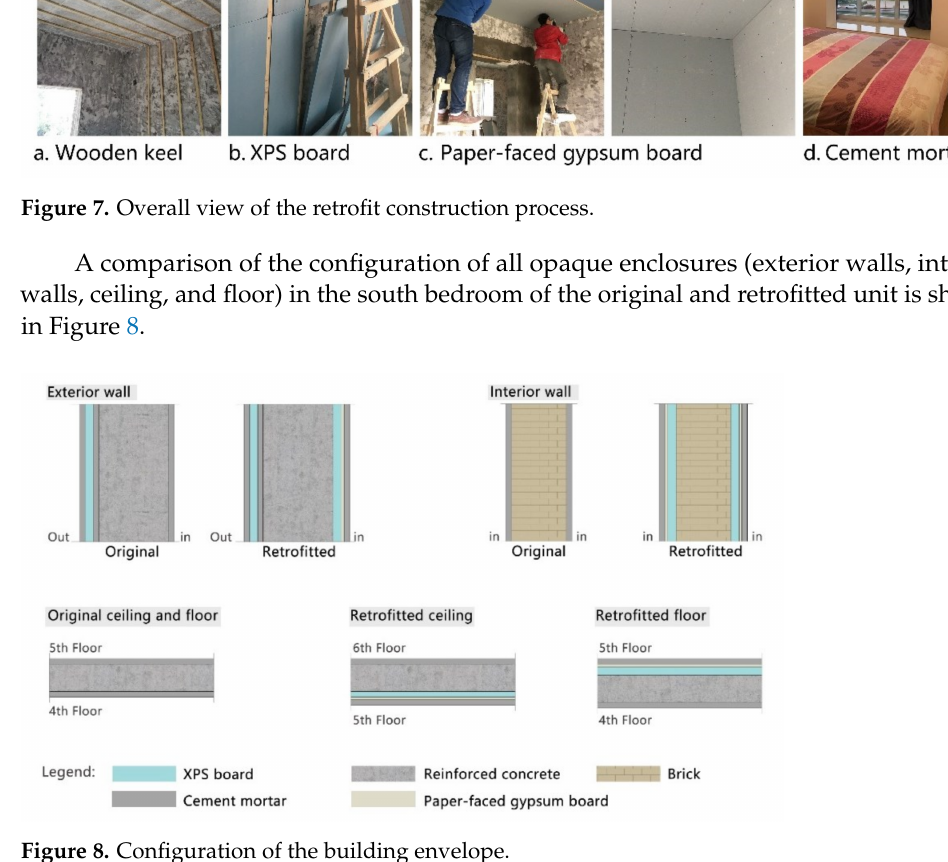
Figure 8. Configuration of the building